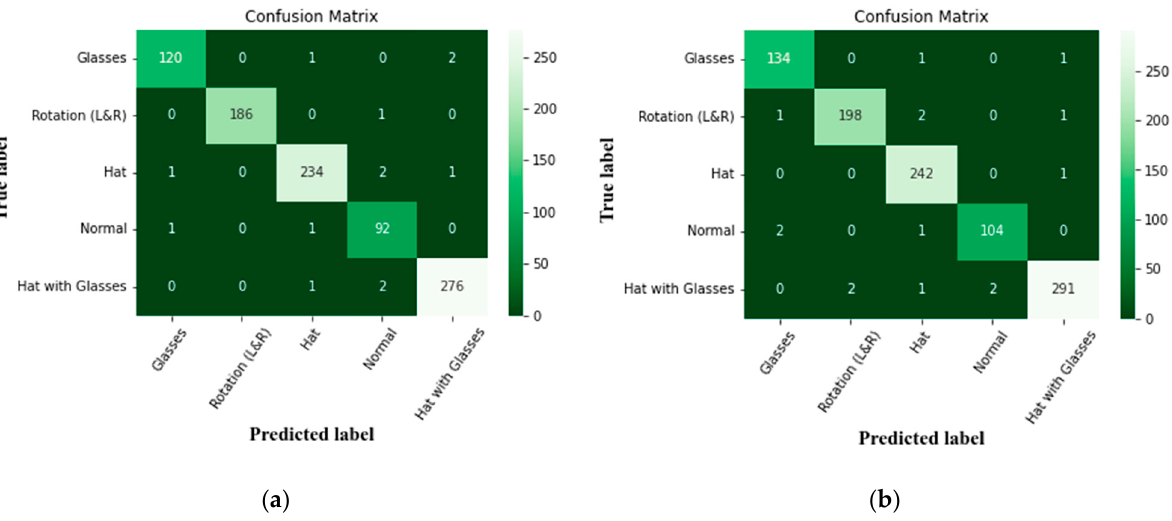
Figure 11. Confusion matrix of face objects ( a ) without optimization, and ( b ) with optimization.